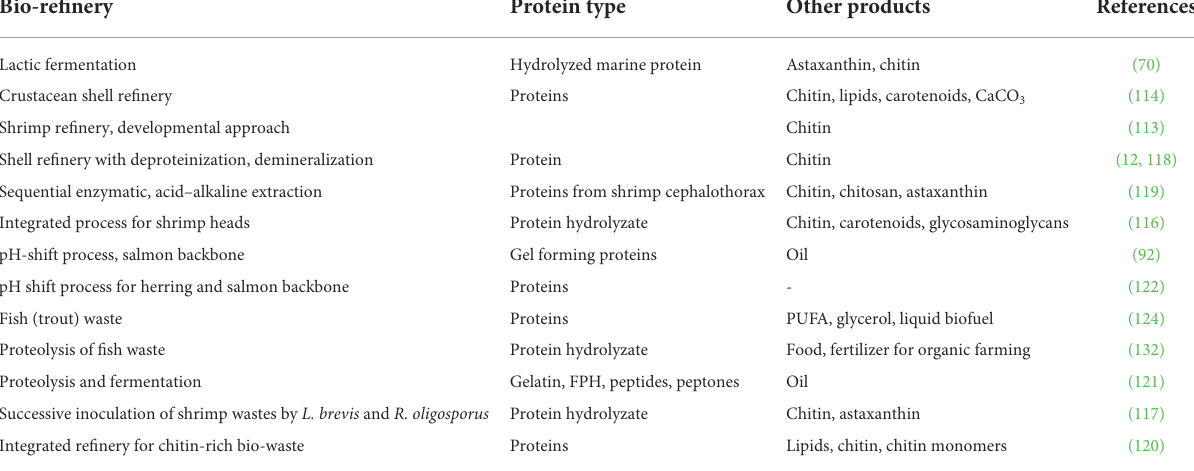
TABLE 3 Recent studies on biorefineries for the recovery of proteins and other products from seafood side streams.